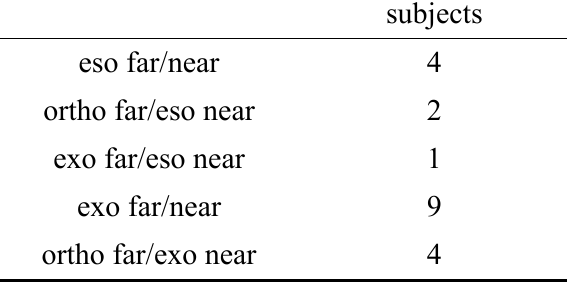
Table 2: Distribution of far and near cover test.